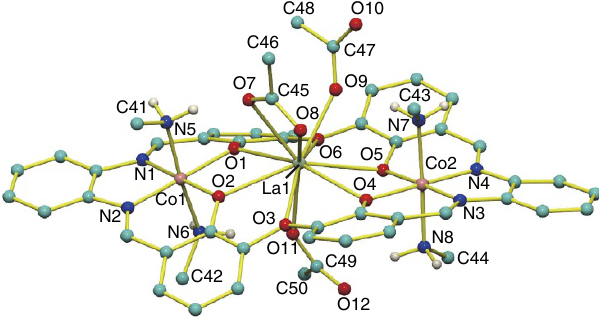
Figure 5 | X-ray crystal structure of [1 (cid:2) La(OAc) 3 ](OTf) 2 . Hydrogen atoms are omitted for clarity except for those of the NH 2 groups. The solvent molecules and two triflate anions are also